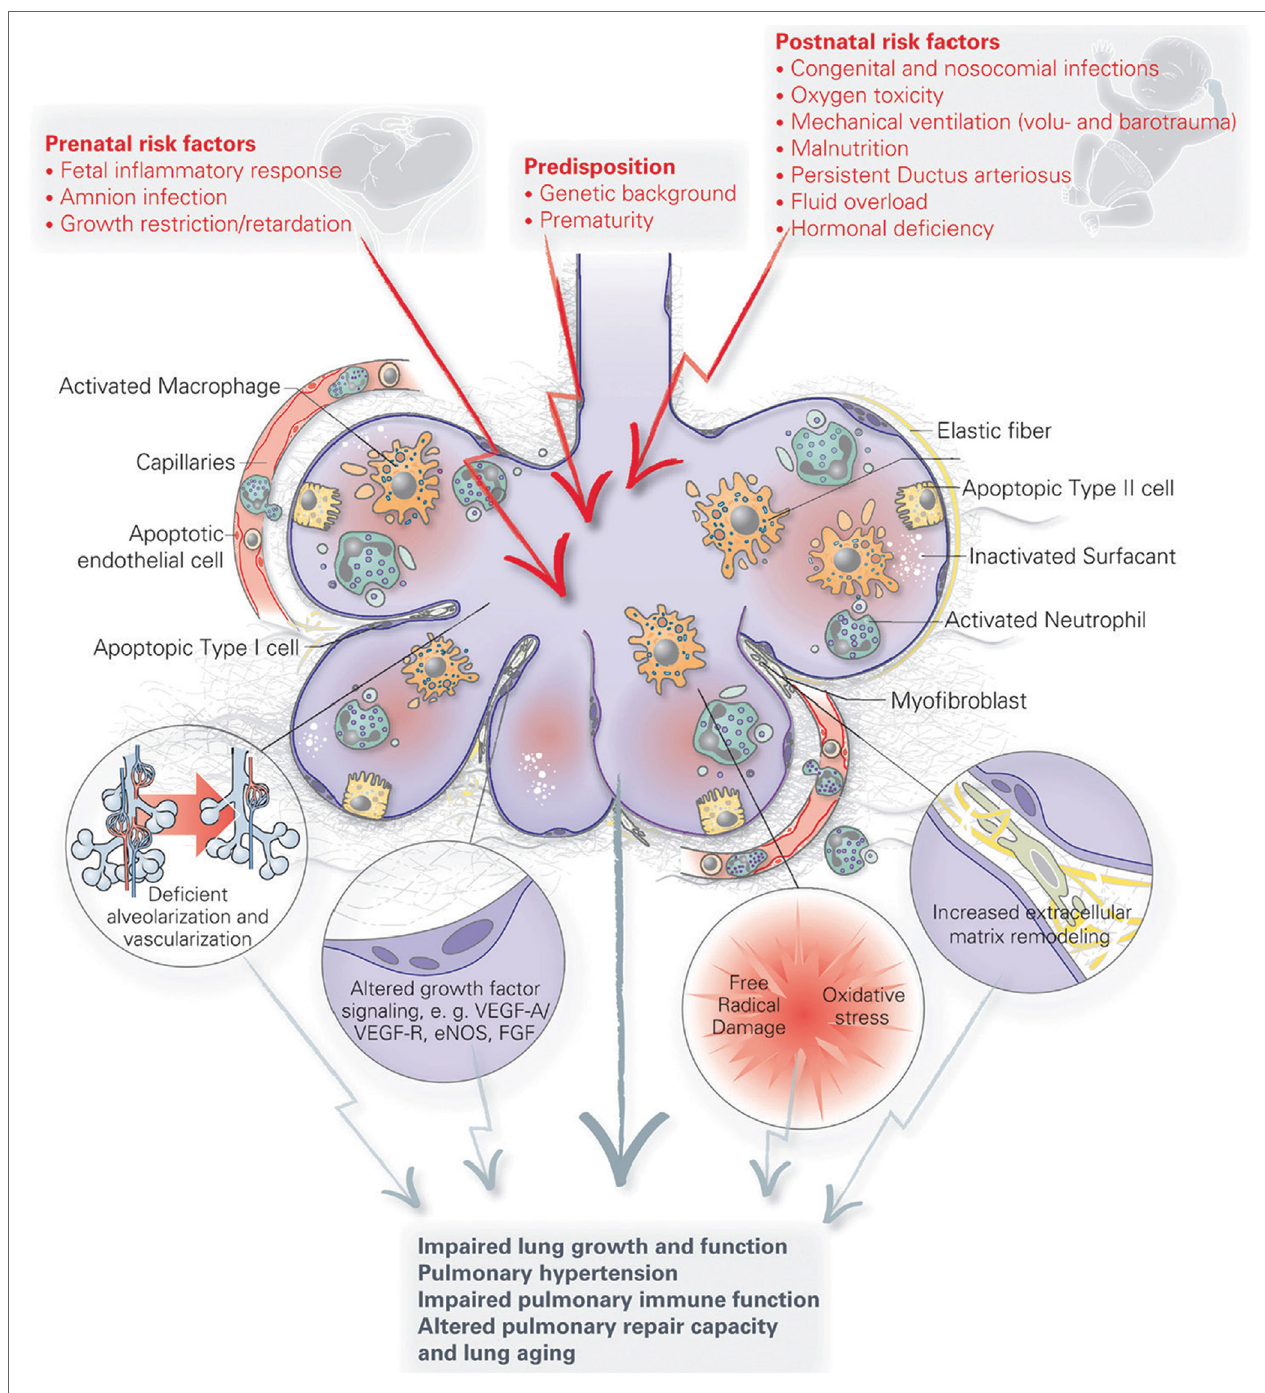
FigURe 2 | A schematic overview of the pathophysiology of bronchopulmonary dysplasia (BPD) . Pre- and postnatal risk factors lead to lung injury, resulting in apoptosis of distal lung cells, inflammation, extracellular matrix remodeling and altered growth factor signaling. These have long term effects on lung growth and function, including vascular and immune function, resulting in an increased disposition for chronic lung disorders. Figure reprinted from Hilgendorff and O’Reilly, originally published by Frontiers in Medicine